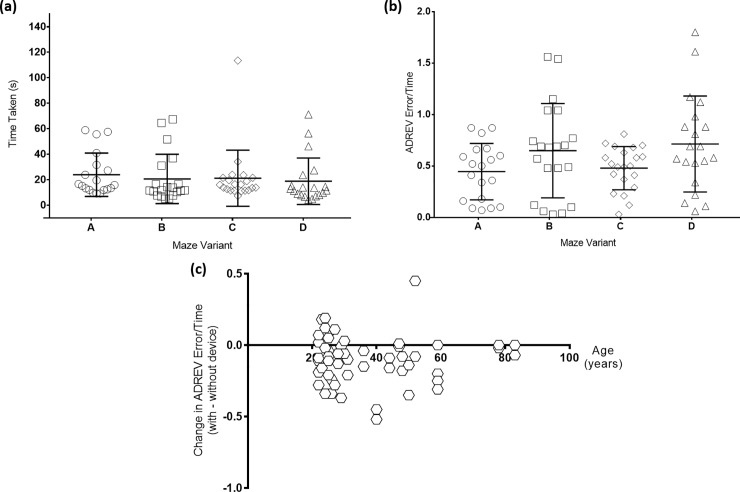
Analysis of confounding variables.Repeated maze attempts from sighted subjects revealed that maze variant (A to D) used had no significant effect on time taken to complete each maze, measured in seconds, (p = 0.380) (a) or ADREV error/time scores (p = 0.182) (b). Age of all subjects, in years, was found to not be statistically correlated with change in ADREV error/time score (p = 0.9187) (c).